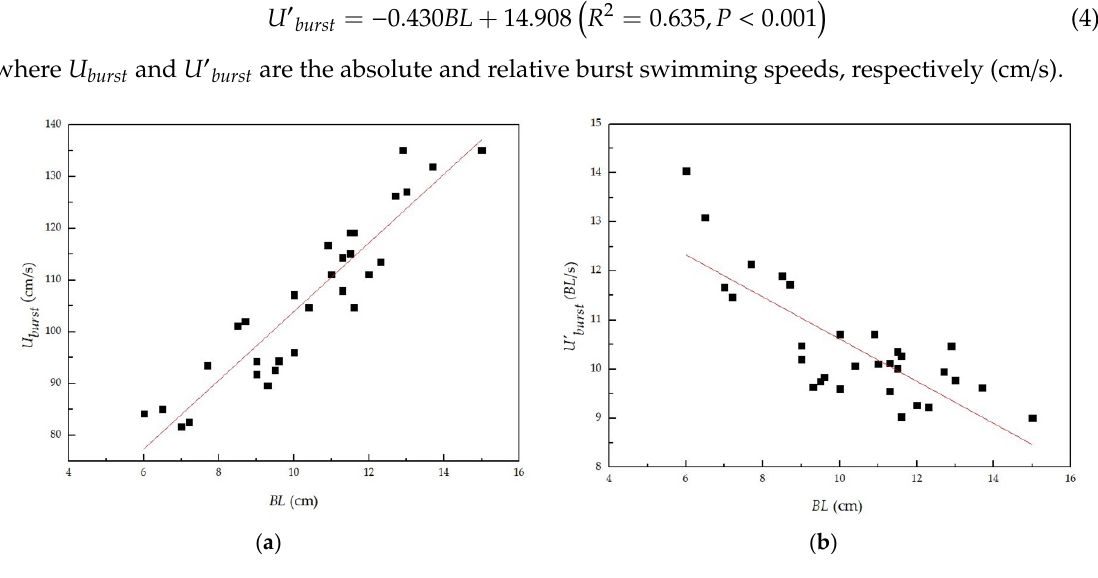
Figure 5. Relationship between absolute/relative burst swimming speeds and body lengths of tested juvenile grass carp: ( a ) Relationship between absolute burst swimming speeds and body lengths; ( b ) Relationship between relative burst swimming speeds and body lengths.